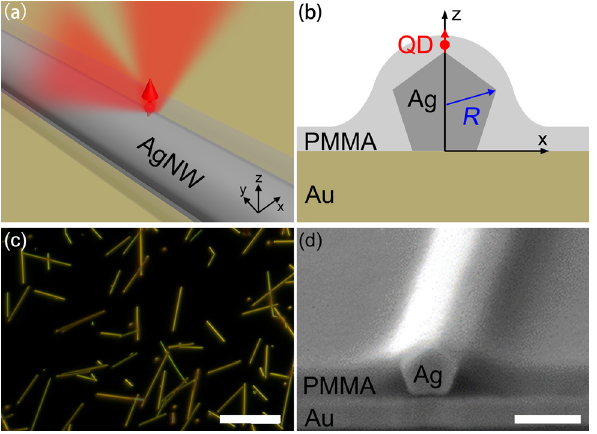
Figure 1: (a) Schematic diagram of the metallic nanostructure comprising a silver nanowire placed on a metal substrate. A quantum dot is located above the silver nanowire. (b) Cross section of the proposed structure in the x-z plane with y = 0 μ m. The radius ( R ) of the sliver nanowire is de fi ned as the distance between thecenteranda vertexof thepentagon.(c)Dark- fi eldimageof silver nanowires placed on a gold substrate. The scale bar is 20 μ m. (d) scanning electron microscopy image of the cross section of one ofthesilvernanowiresplacedonthegoldsubstrate.Thescalebaris 200 nm.